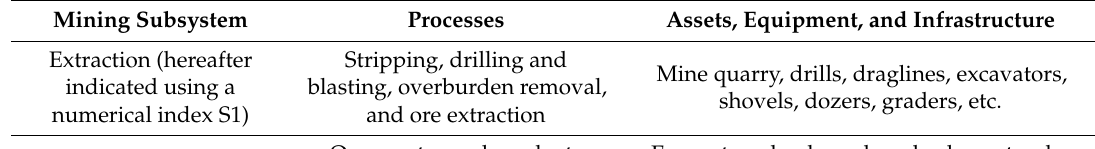
Table 1. Subsystems of the mining industry considered in the present